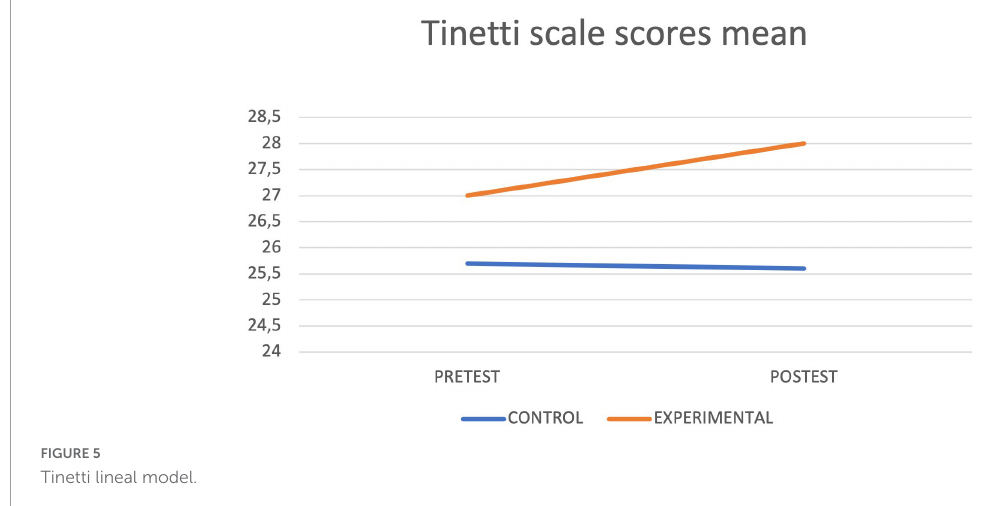
FIGURE5 Tinetti lineal model.